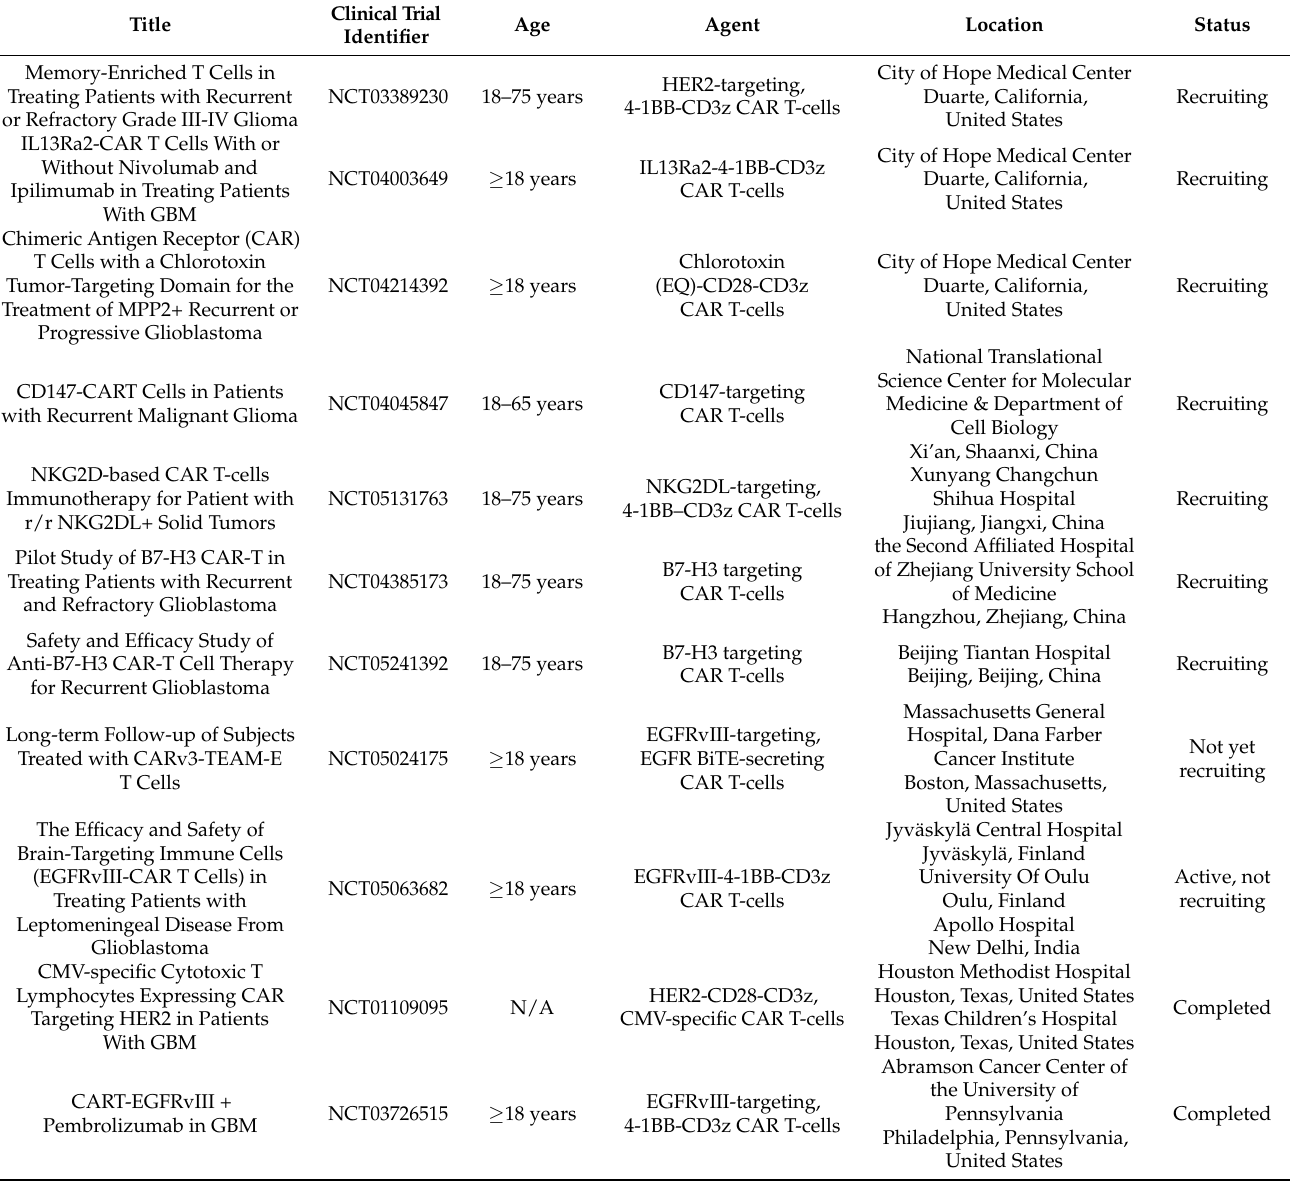
Table 1. CAR T-cell trials in GBM registered with Clinicaltrials.gov (accessed on 18 February 2022). The following represents current clinical trials of CAR T-cells in adult GBMs registered with clinicaltrials.gov as of 18 February 2022. In some cases, details of the trial agent are